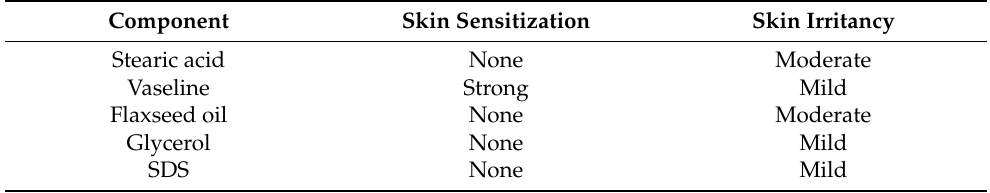
Table 3. Prediction of skin sensitivity and skin irritation in